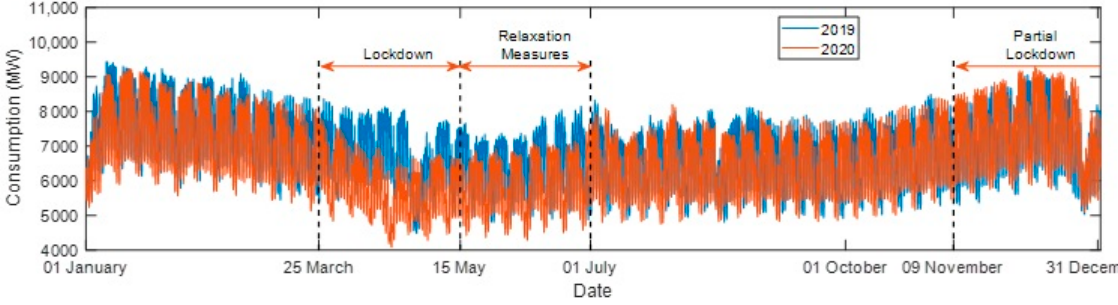
Figure 1. Electricity consumption in Romania in 2019 and 2020.